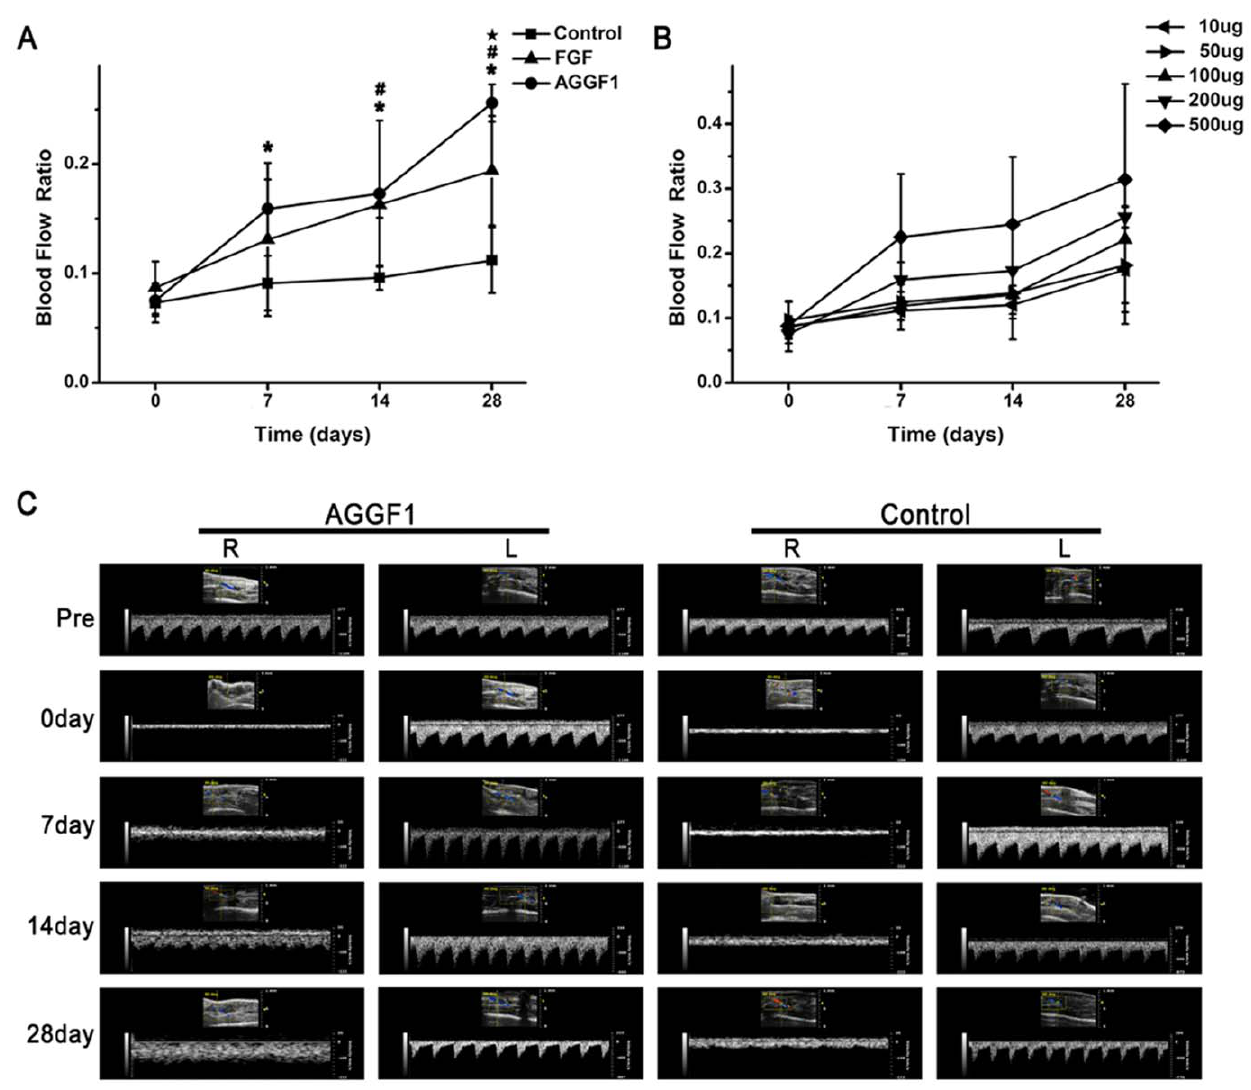
Figure 2. Effects of gene transfer for human AGGF1 by intramuscular administration of plasmid DNA on blood flow in a mouse ischemic hindlimb model. A ) Injection of AGGF1 plasmid DNA increased blood flow compared to injection of DNA for an empty vector (control). FGF-2 plasmid DNA was used as a positive control. The right femoral artery was ligated to mimic unilateral hindlimb ischemia. One group of ischemic mice received DNA for a human AGGF1 expression plasmid, and the other group received DNA for a control empty plasmid one day after the ligation surgery. The ratio of blood flow in the ischemic leg over that in the nonischemic limb at the indicated time points (in days) was plotted. The blood flow was measured by high resolution microultrasound. B ) Dose-response curve of blood flow for varying amounts of AGGF1 plasmid DNA. C ) Representative images from micro-ultrasound. R, ischemic leg undergone surgery and ligation; L, leg undergone mock surgery. *, P , 0.05 for comparing AGGF1 vs control at the same time point; # , P , 0.05 for comparing FGF2 vs control at the same time point; w , P , 0.05 for comparing AGGF1 vs FGF2 at the same time point.